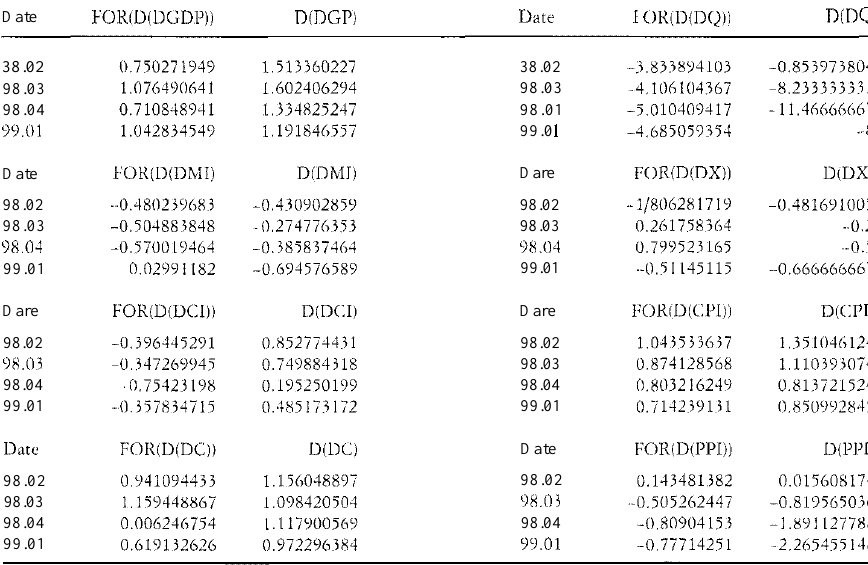
Control forecasts, defhtor model, qcq growth